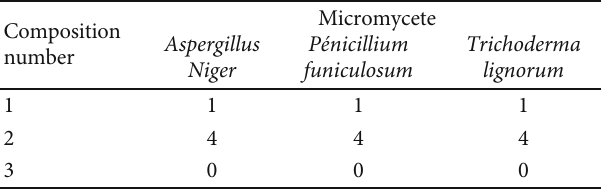
Table 5: Evaluation of the biostability of PVC composites in